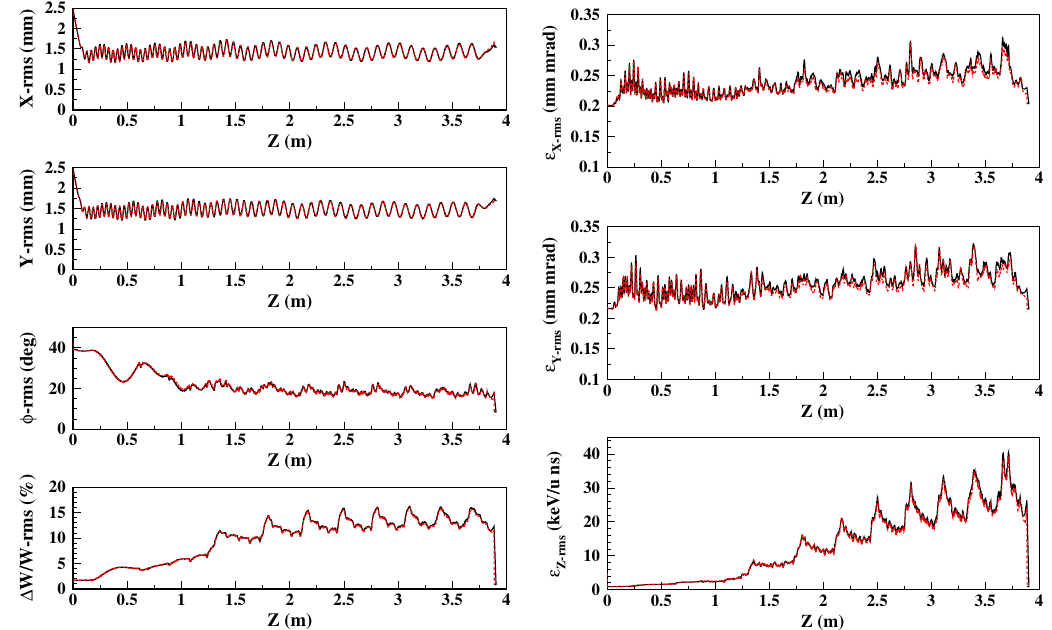
FIG. 7. Comparison between the eight-term potential (solid black) and the 3D cell-by-cell model (dashed red) for the original sinusoidal design. On the left are the rms beam envelopes and on the right the rms beam emittances along the RFQ. The curves include all particles within the aperture (accelerated or not). The peaks and valleys on the longitudinal plots correspond to oscillations of nonaccelerated particles extending the longitudinal beam tail.